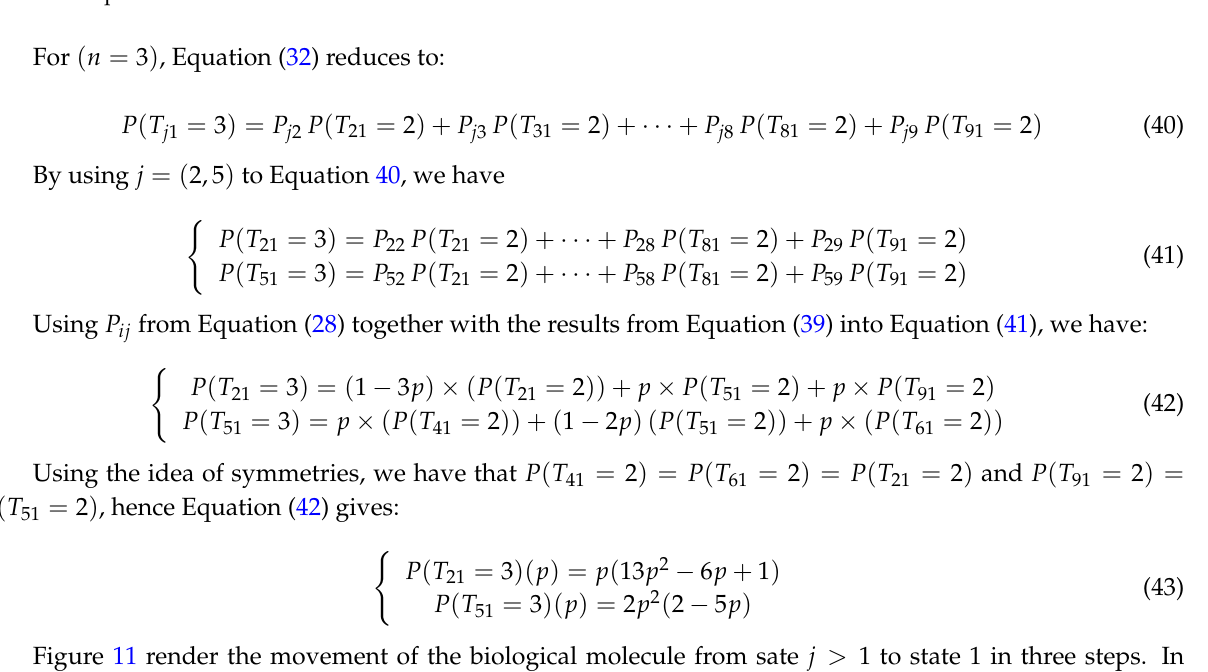
Figure 10. Square tiling in small complex two depict the movement of the particle from state j > 1 to state 1 in two steps.